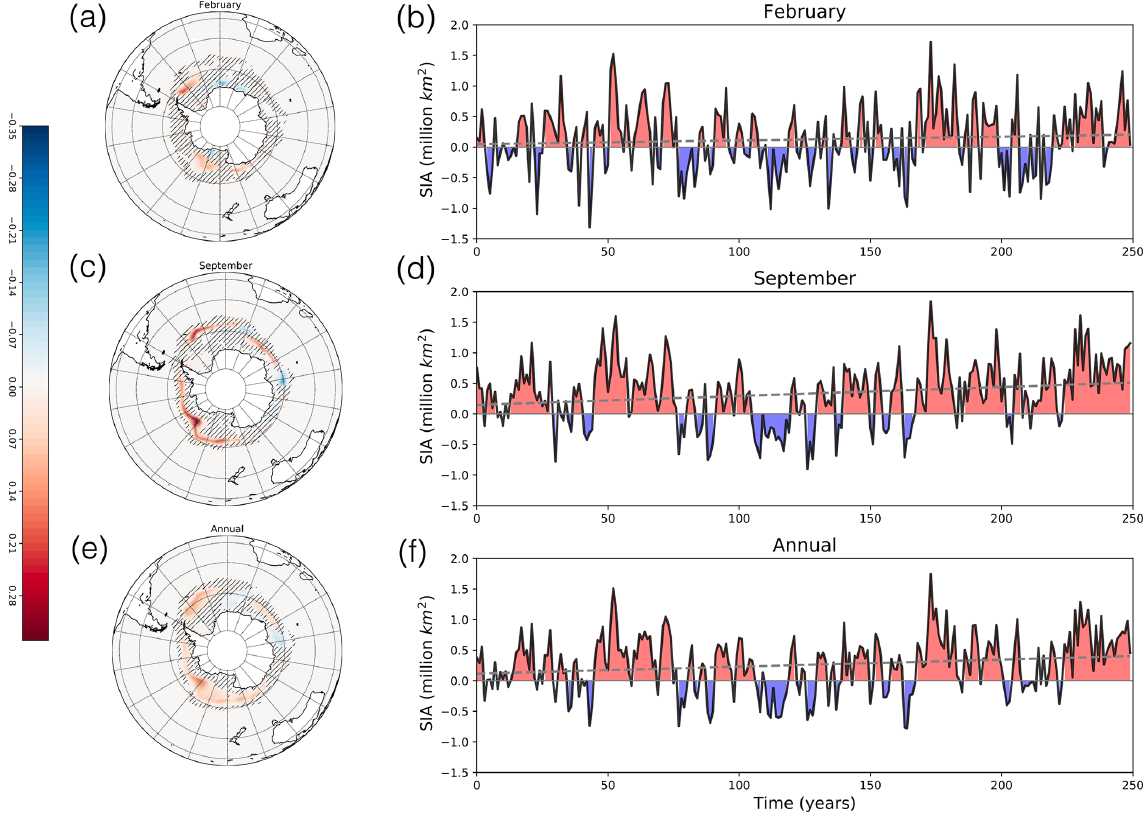
Figure 12. February (a) , September (c) , and annual (e) LIG_hosing–LIG sea ice concentration (SIC) anomalies for the last 100 years of the LIG_hosing simulation. Non-hatched areas correspond to statistically significant differences (at 95% confidence). Panels (b) , (d) , and (f) are time series of February (b) , September (d) , and annual (f) LIG_hosing–LIG sea ice area (SIA) anomalies computed against the LIG climatological mean from year 0 to 250 of simulation. Dashed grey lines represent best fit for data. The trend is positive and statistically significant ( p value < 0.05) for September (d) and annual (f) time series and still positive but not significant ( p value > 0.05) for the February (b) time